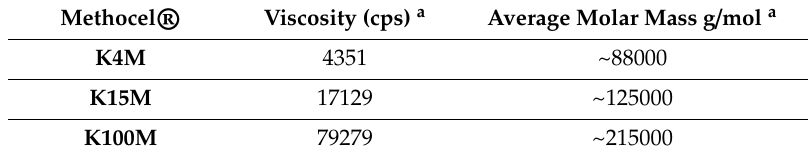
Table 1. Specifications of di ff erent hydroxypropyl methyl cellulose (HPMC) grades used in this